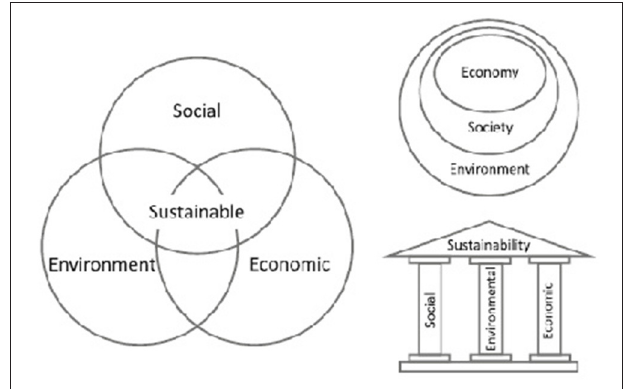
FIGURE 1 | The concept of the three pillars of sustainability (adapted from Purvis et al., 2019).